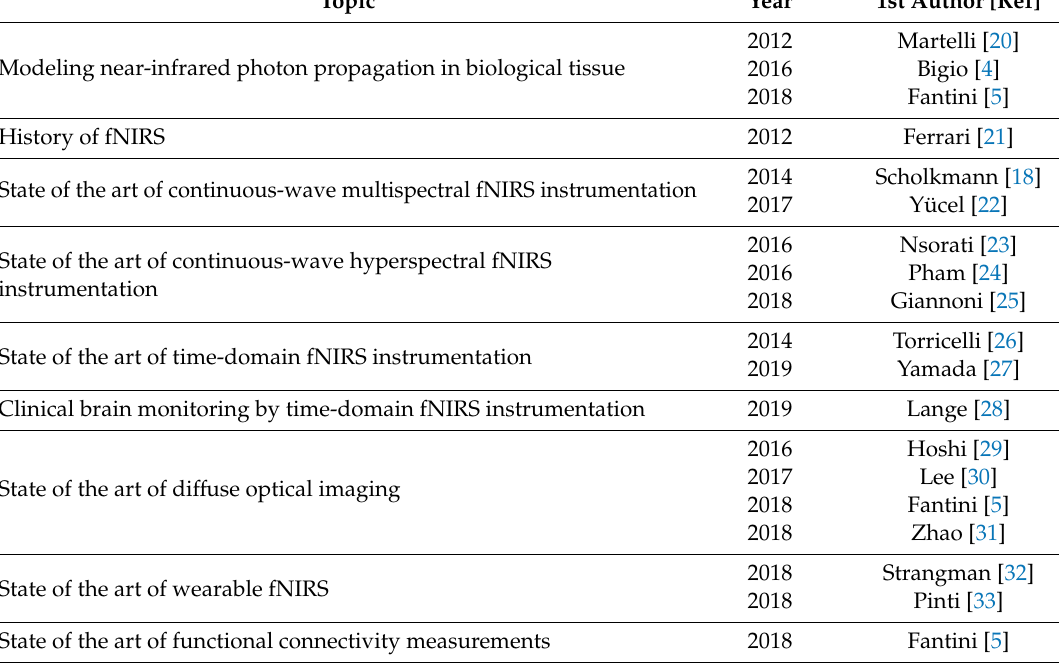
Table 1. Most relevant references about functional near-infrared spectroscopy (fNIRS): Basics and technical